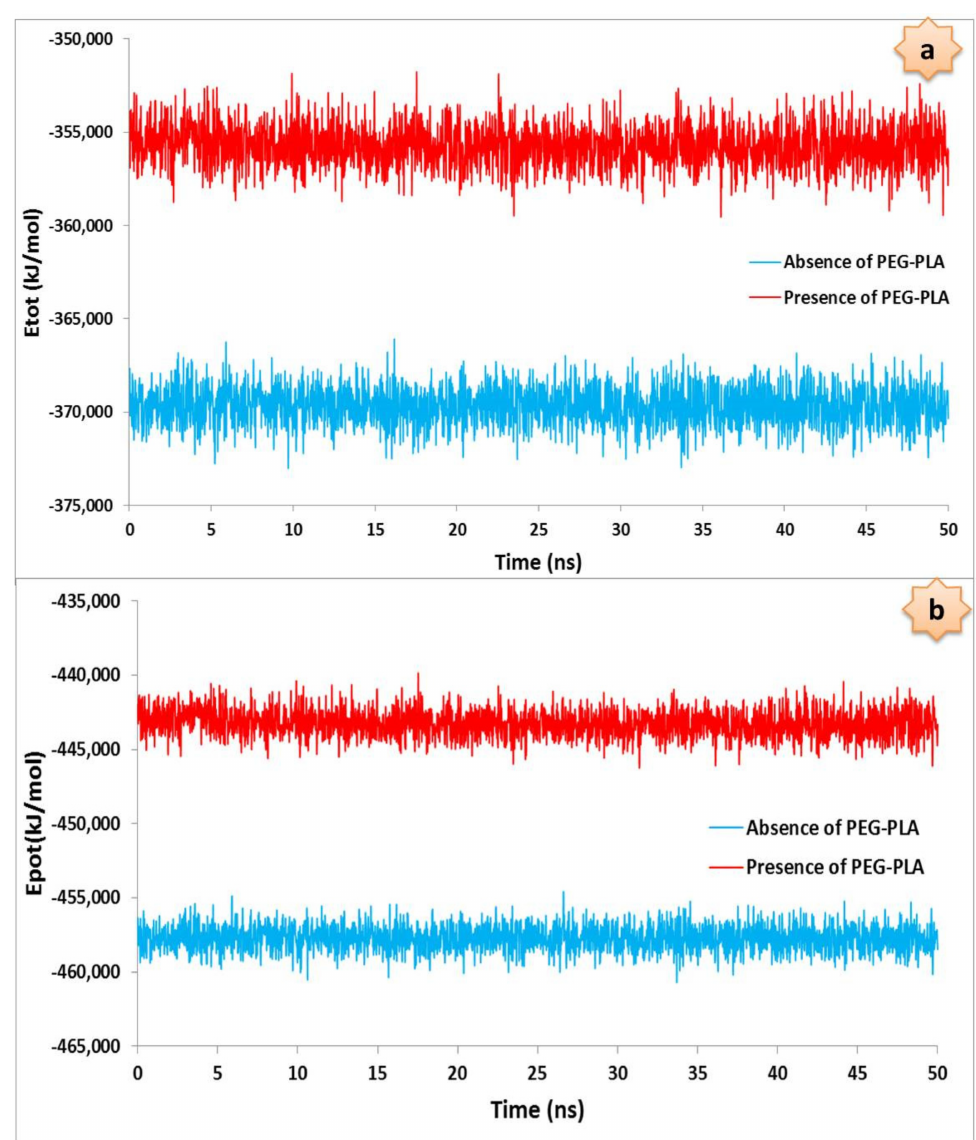
Figure 4. Total ( a ) and potential ( b ) energies for the docetaxel anticancer drug loading onto graphene quantum dot oxide in the presence and absence of the PEG-PLA